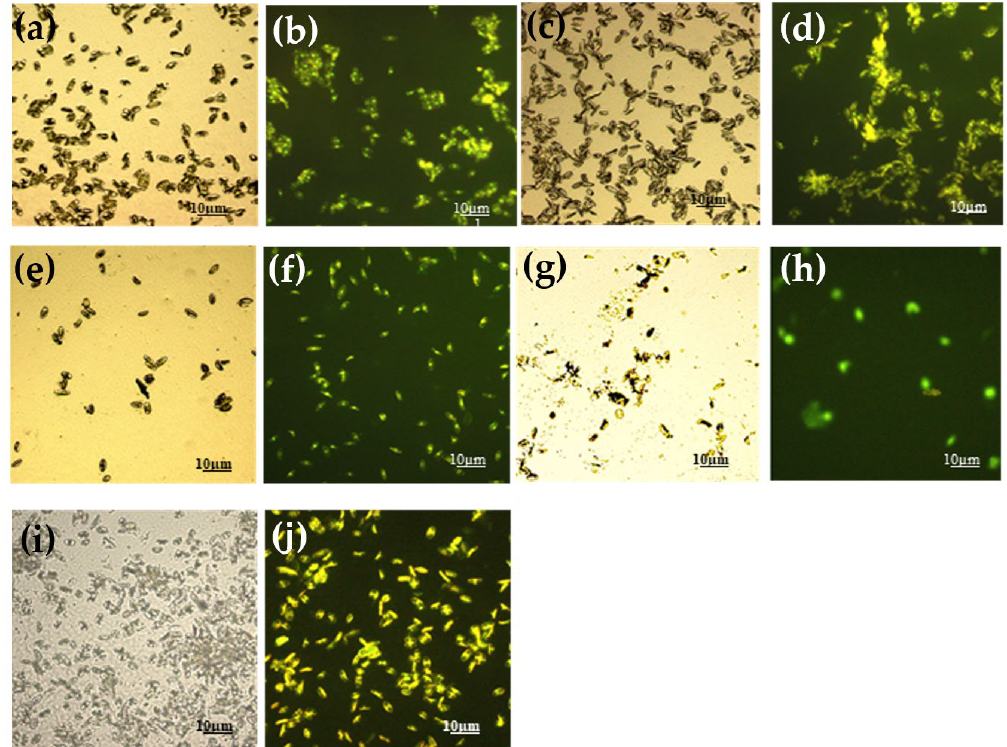
Figure 14. Images of the slides treated and not in contact with Navicula sp . obtained with the light microscope and with the epifluorescence microscope 20× magnification. ( a , b ) Control; ( c , d ) G_A; ( e , f ) G_A_F3; ( g , h ) G_A_F16; ( i , j ) G_A_F3_F16. Note that figures g and h (G_A_F16) showed suffer- ing and ghost